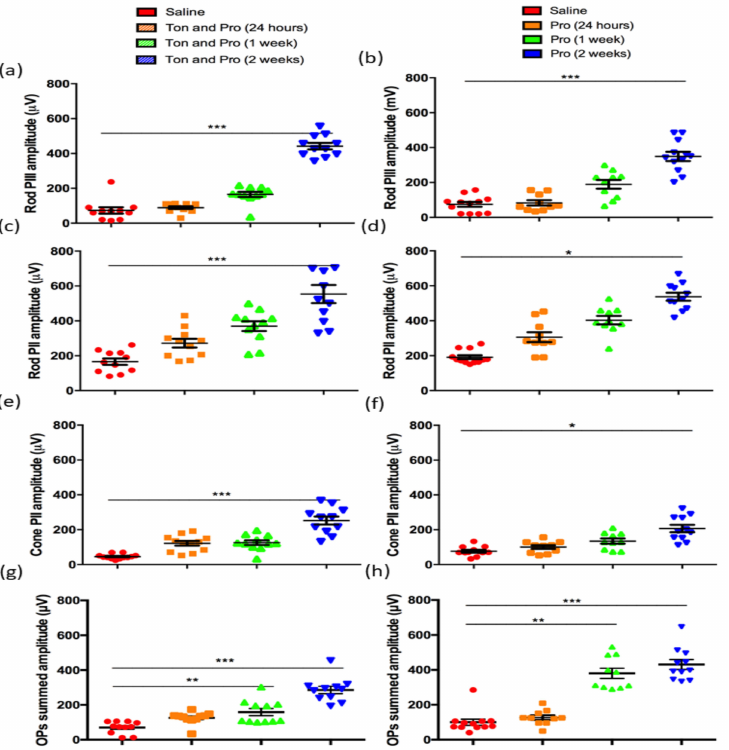
Figure 2. Representative rod PIII, rod PII and cone PII amplitudes of tonabersat with probenecid, probenecid and saline injected light-damaged rats. Rod PIII amplitude recovery is shown for the tonabersat with probenecid group ( a ) and probenecid alone ( b ). Rod PII amplitudes were also calculated for the tonabersat with probenecid group ( c ) and probenecid alone ( d ). The post- photoreceptor cone PII amplitude for the tonabersat with probenecid group is shown in ( e ) as is probenecid alone ( f ). The tonabersat and probenecid treated group showed a significantly recovered OP summed amplitude transiently at 1 week post-treatment ( g ) whereas the probenecid alone treated group showed greater improvement over time with significantly recovered OP summed amplitudes at 1 week and 2 weeks ( h ). Overall, both treatments resulted in the recovery of retinal function but probenecid showed a faster recovery of inner retinal function at 1 week and greater recovery of the OPs. Statistical analysis was conducted using one-way ANOVA, followed by post-hoc